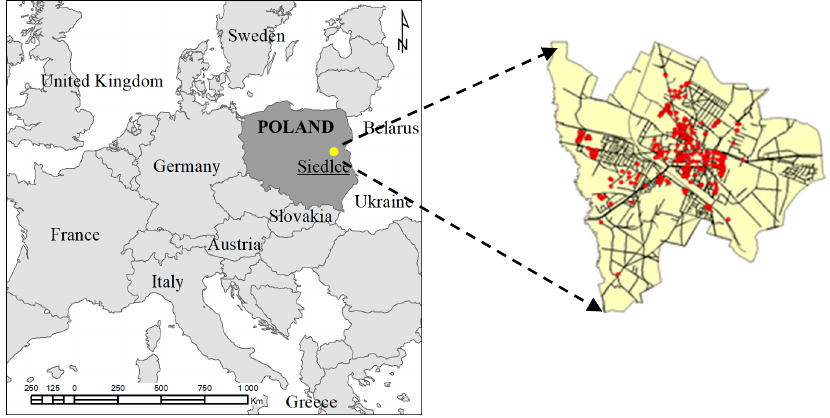
Figure 1. Location of study area and properties being bought and sold in Siedlce.